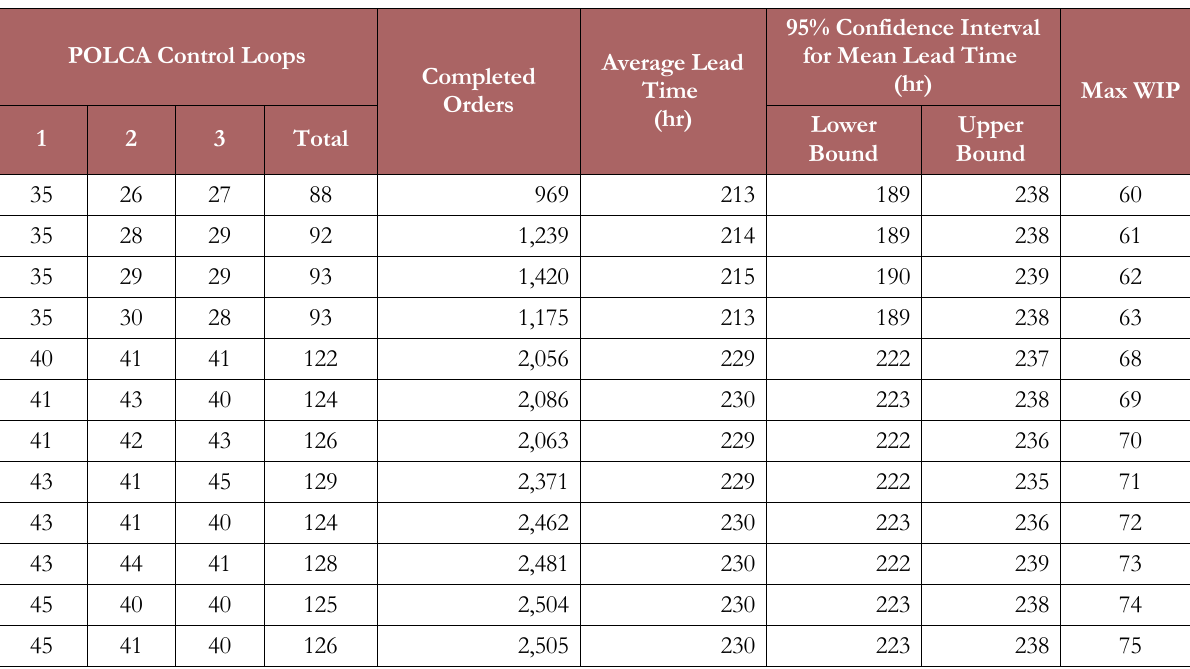
Table 10. POLCA Control Simulation Results – Random